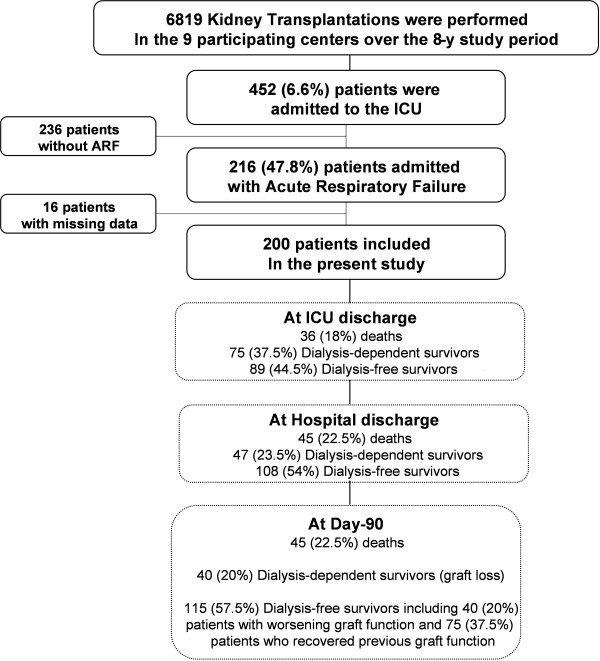
Flowchart of the study.